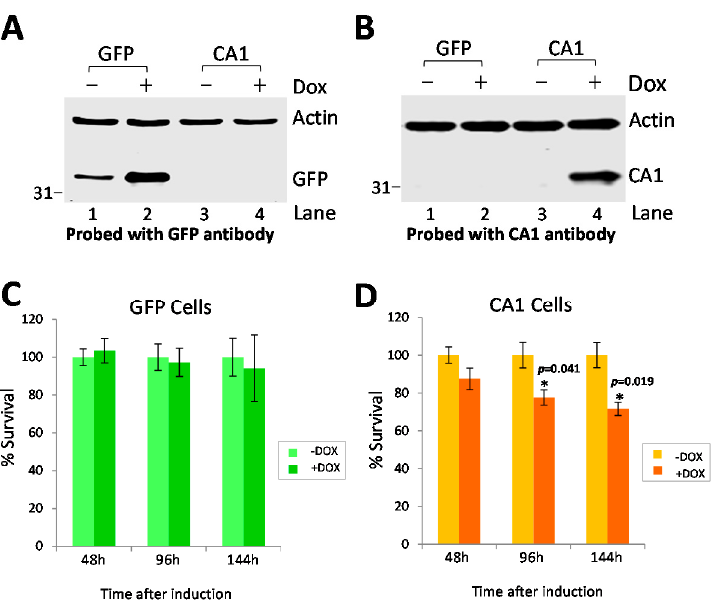
Figure 5. Long-term expression of CA1 decreases HEK293 cell survival. The expression of either GFP or CA1 was induced by 0.25 µ g/mL doxycycline (DOX) in HEK293 cells at different times. The expression of GFP ( A ) and CA1 ( B ) in absence ( − ) and presence (+) of DOX was examined at 96 h by Western blot analysis; CA1 antibody (ab1088367, 1:5000) was used for ( B ); The rate of cell survival was measured by the WST8 assay at the indicated time (48, 96 and 144 h, respectively) in absence ( − ) and presence (+) of DOX for GFP ( C ) and CA1 ( D ). The data are the average of three independent experiments and expressed as “Mean ± SEM”. * indicates p value < 0.05. The p values (not indicated by *) for GFP at 48, 96, 144 h, and CA1 at 48 h are 0.68, 0.80, 0.20, and 0.15, respectively.